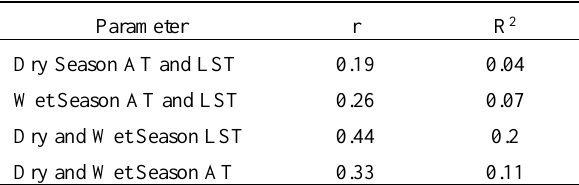
Table 6. Correlation results of seasonal (dry and wet season) and temperature types (LST and AT) in Baguio City